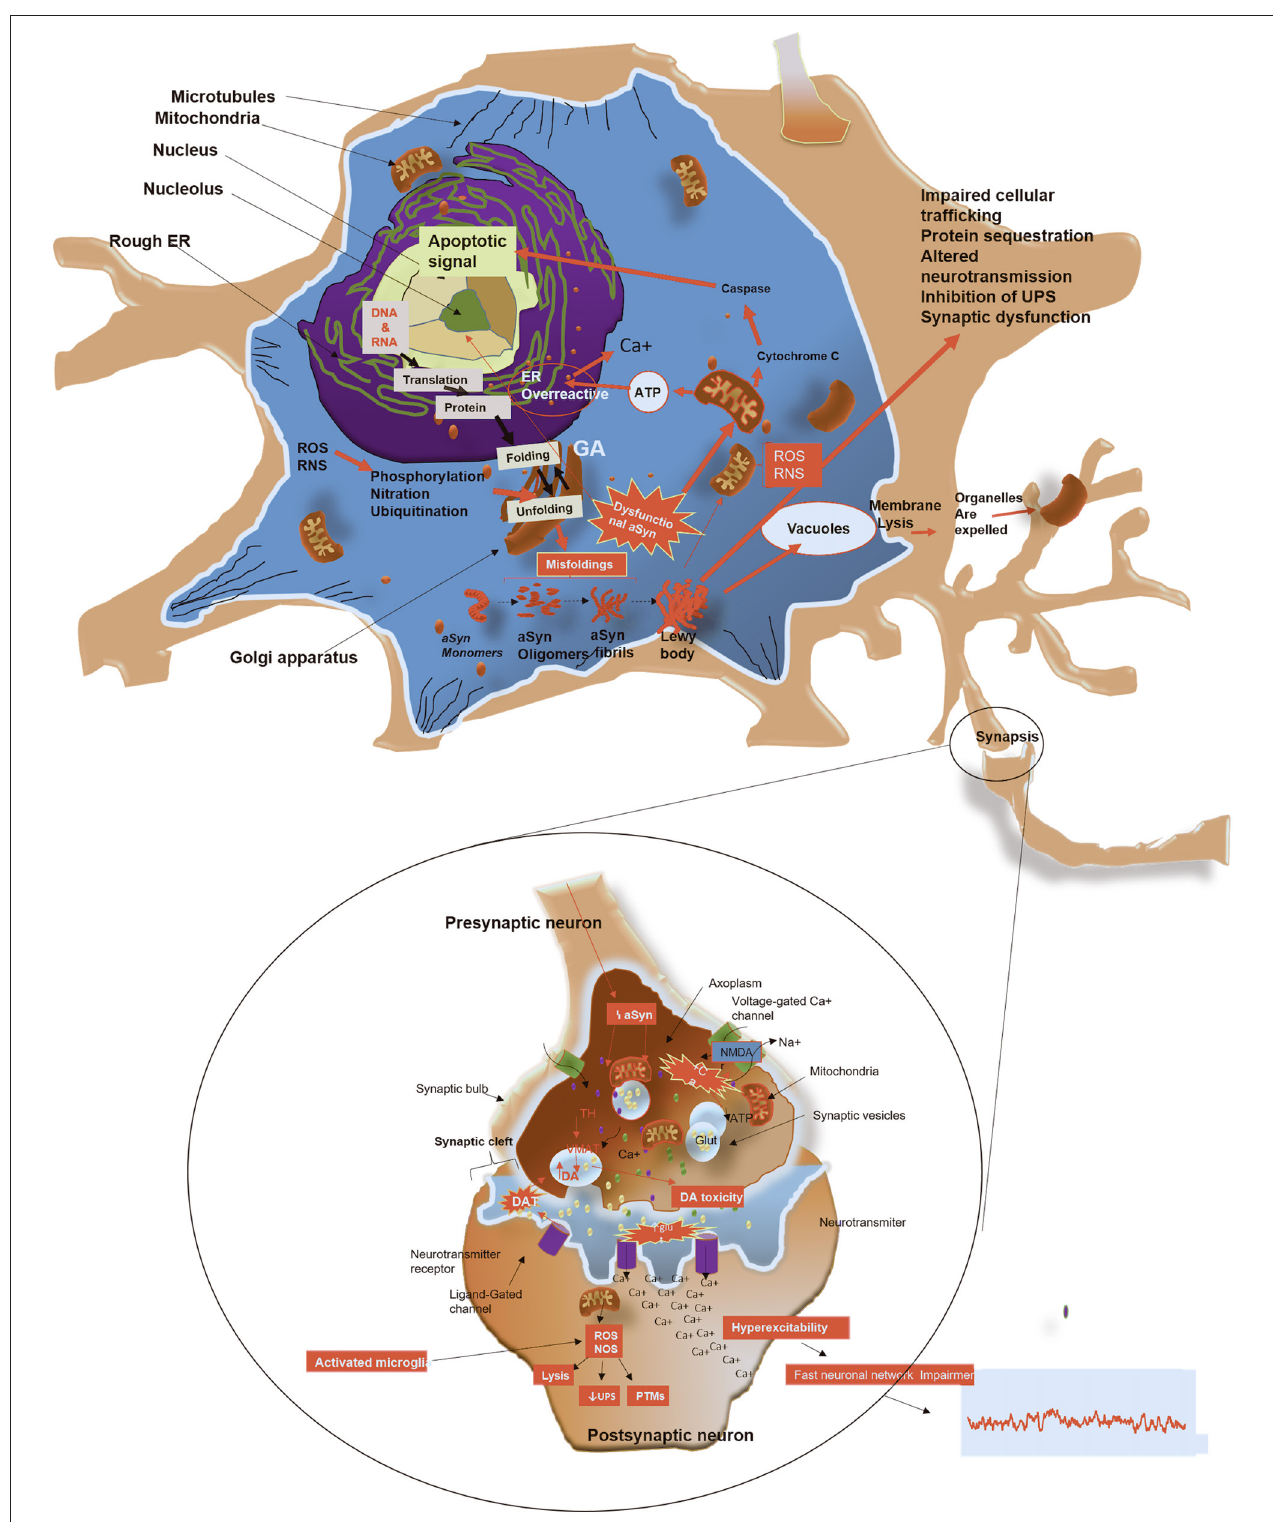
FIGURE 3 | Schematic representation of potential mechanisms by which aSyn form aggregates, leads to toxicity and causes cell death. Monomeric aSyn assembles to form oligomers and producing mature fibrils. (1) LBs and LNs formation: fibrillary forms of aSyn are segregated into protein inclusions, which contain dysmorphic organelles, vesicular structures and various other cellular proteins, depleting cells of these vital components. (2) Mitochondrial impairment: Altered aSyn translocate to